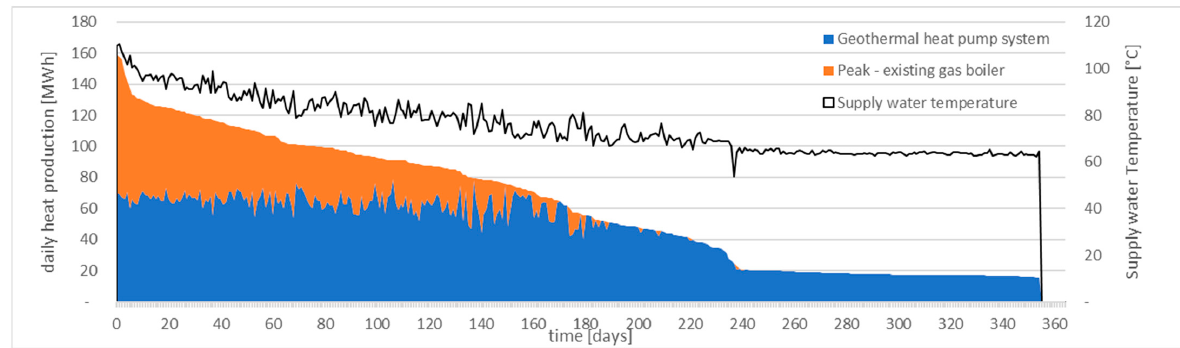
Figure 11. Accumulated daily heat production in 2019 with a breakdown of heat sources.